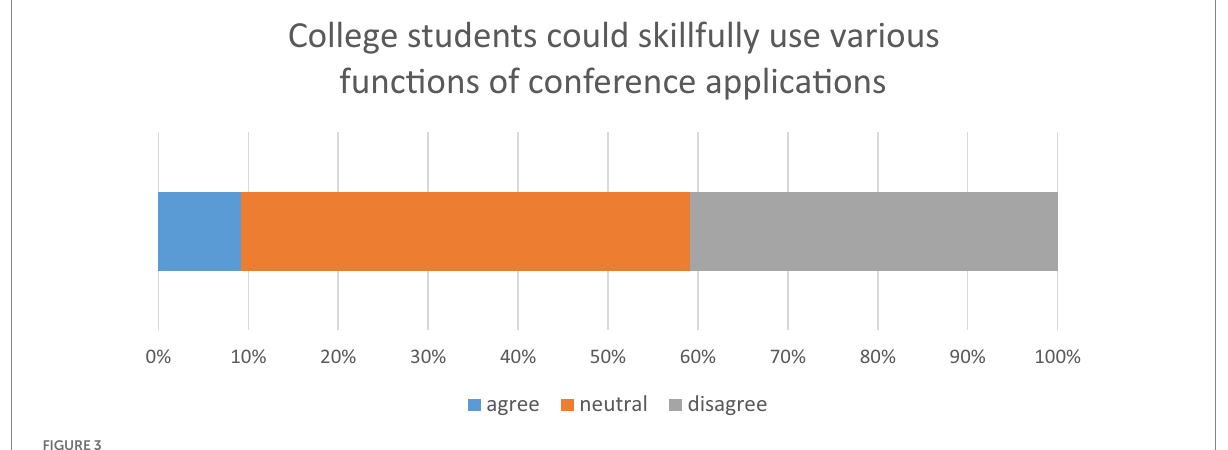
FIGURE 3 Distribution of user’s familiarity with the features on virtual conferencing